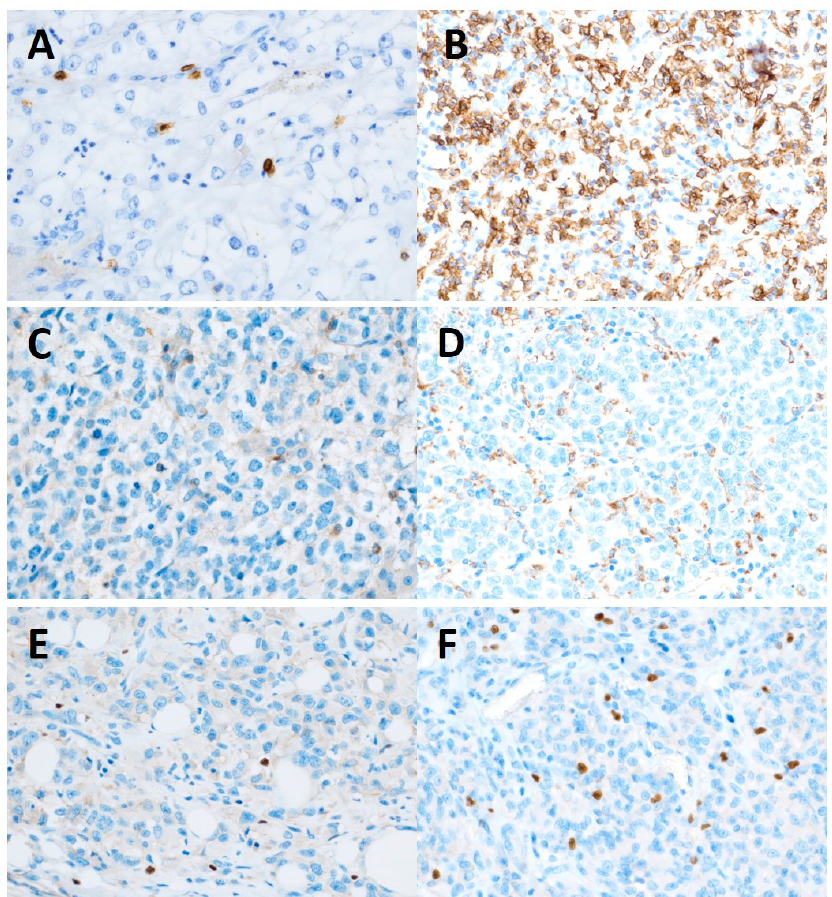
Figure 1. Immunohistochemical staining of samples under microscope (magnification: 200×). ( A ) CD8 intraepithelial expression low. ( B ) CD8 intraepithelial expression high. ( C ) Negative expression of CD68. ( D ) Positive expression of CD68. ( E ) Negative expression of FoxP3. ( F ) Positive expression of FoxP3.